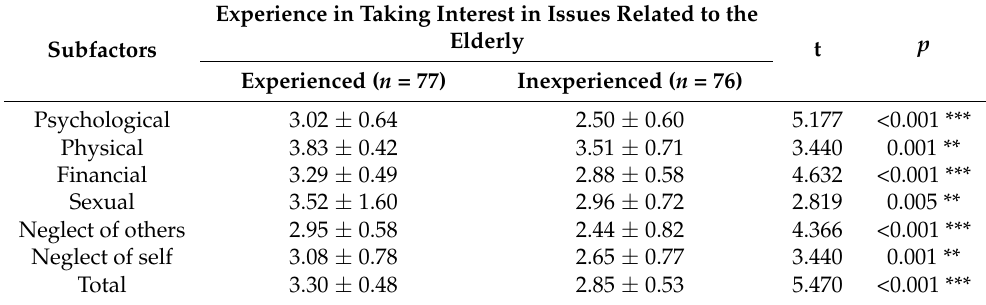
Table 5. Perceived degrees of violation of human rights of the elderly according to the experience of taking interest in issues related to the elderly M ±